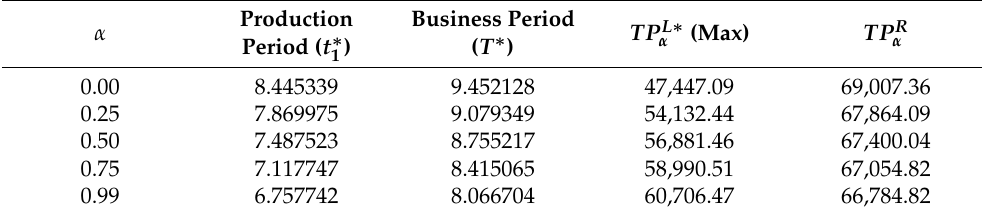
Table 11. Optimum results of Example 4 for maximizing TP L α .